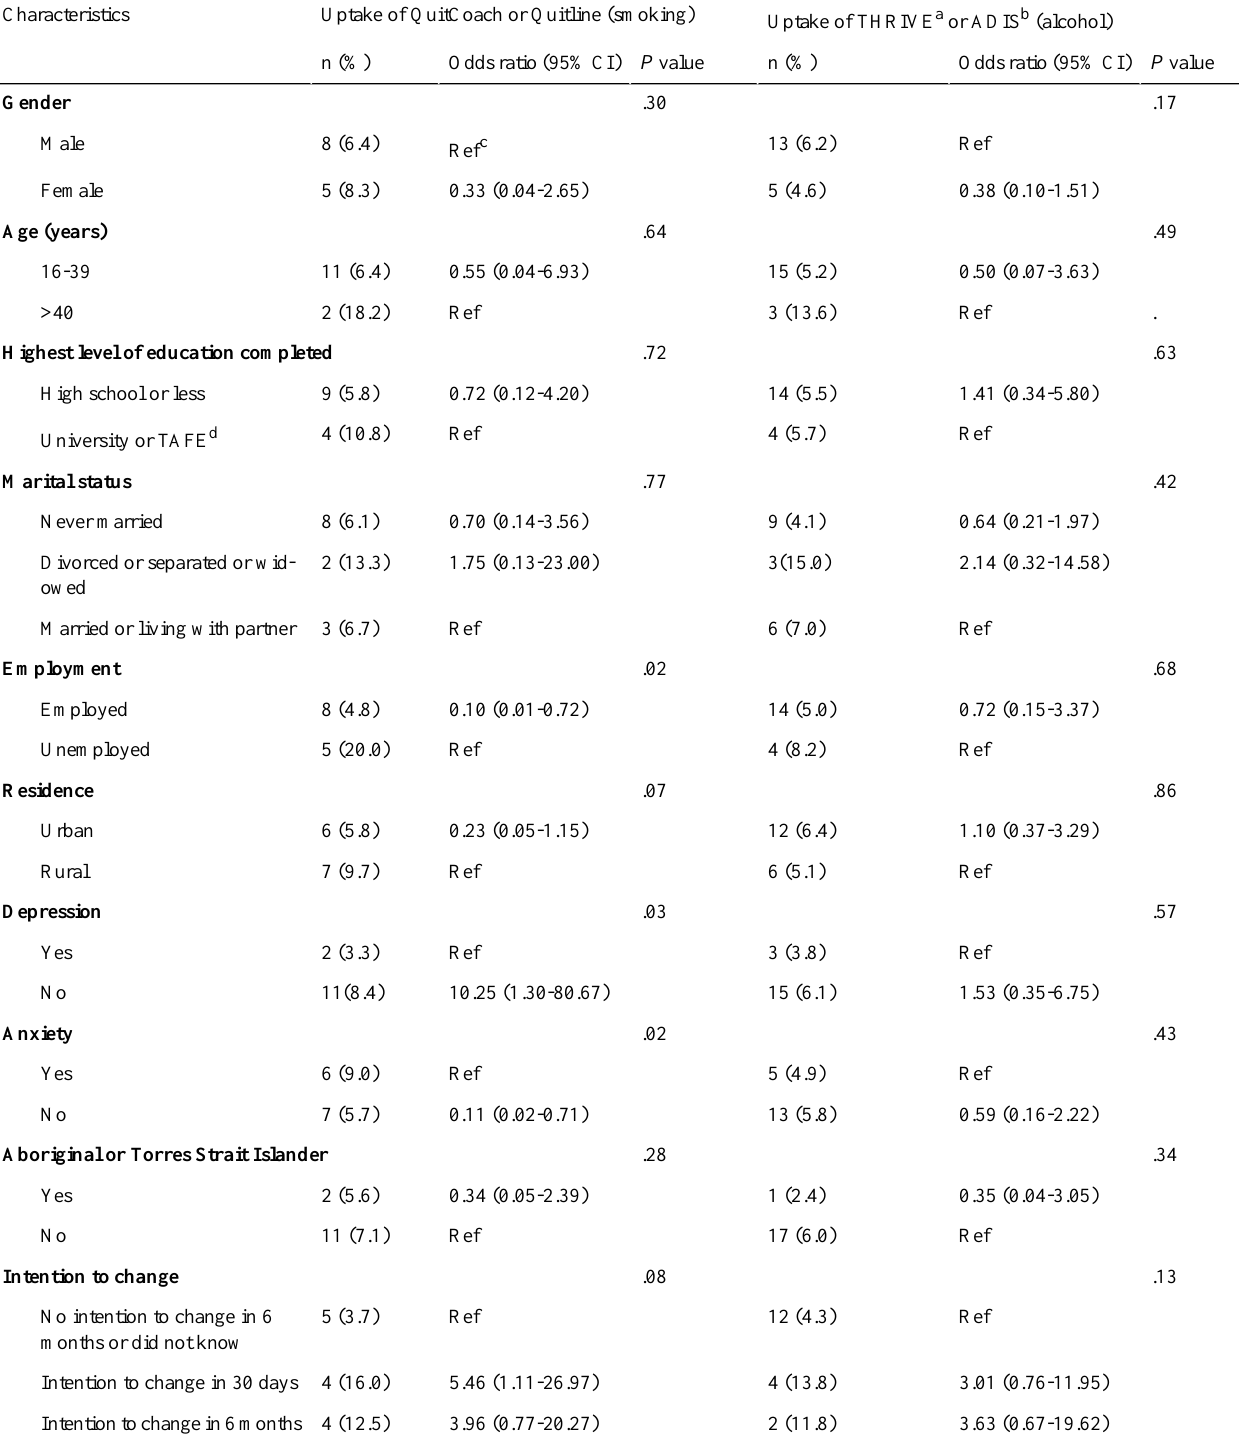
Table 4. Characteristics associated with uptake of telephone or online support services for smoking and alcohol consumption.